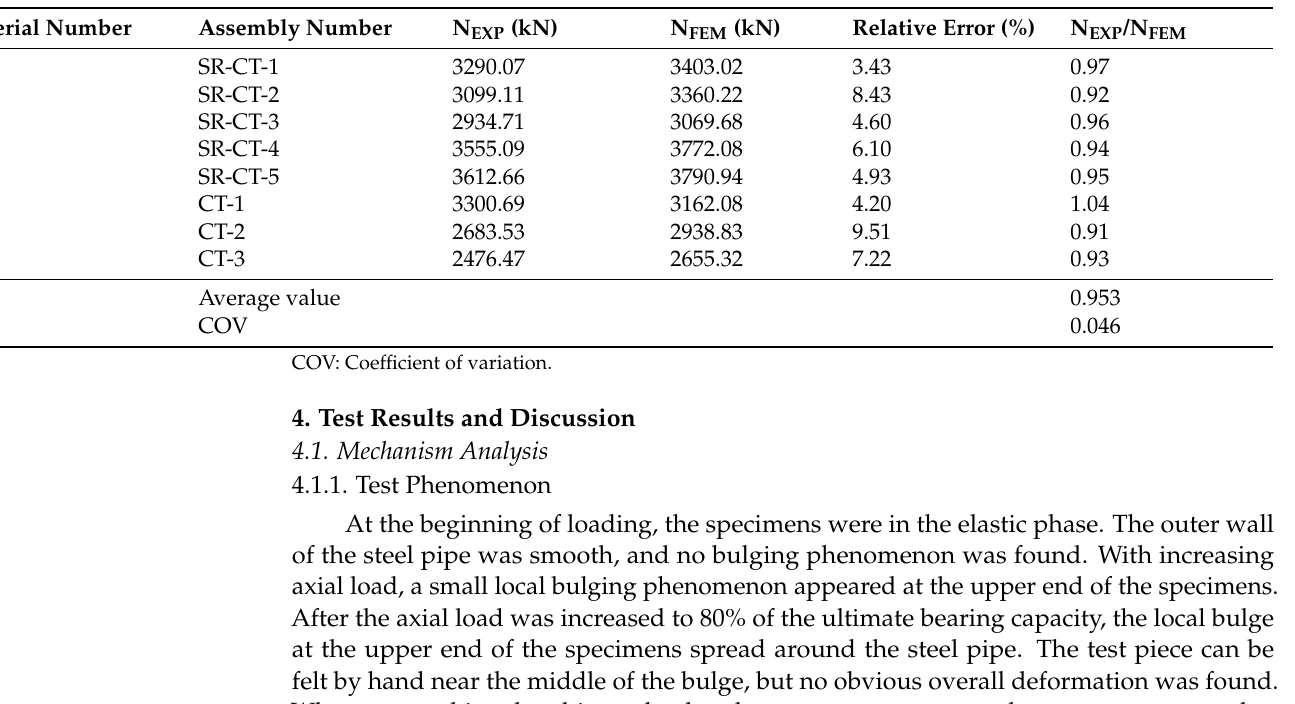
Table 7. Error analysis of ultimate bearing capacities from experiments and